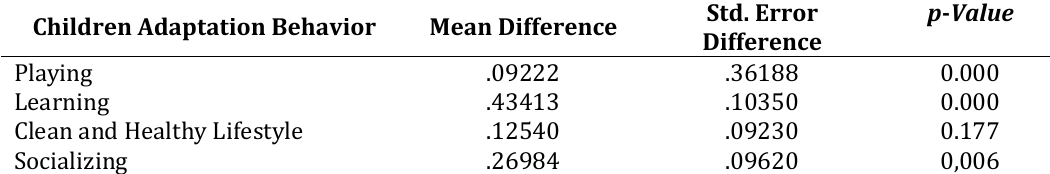
Children’s Adaptive Behavior Toward Playing, Learning, Clean and Healthy Lifestyle, and Socializing Activities After Intervention Between